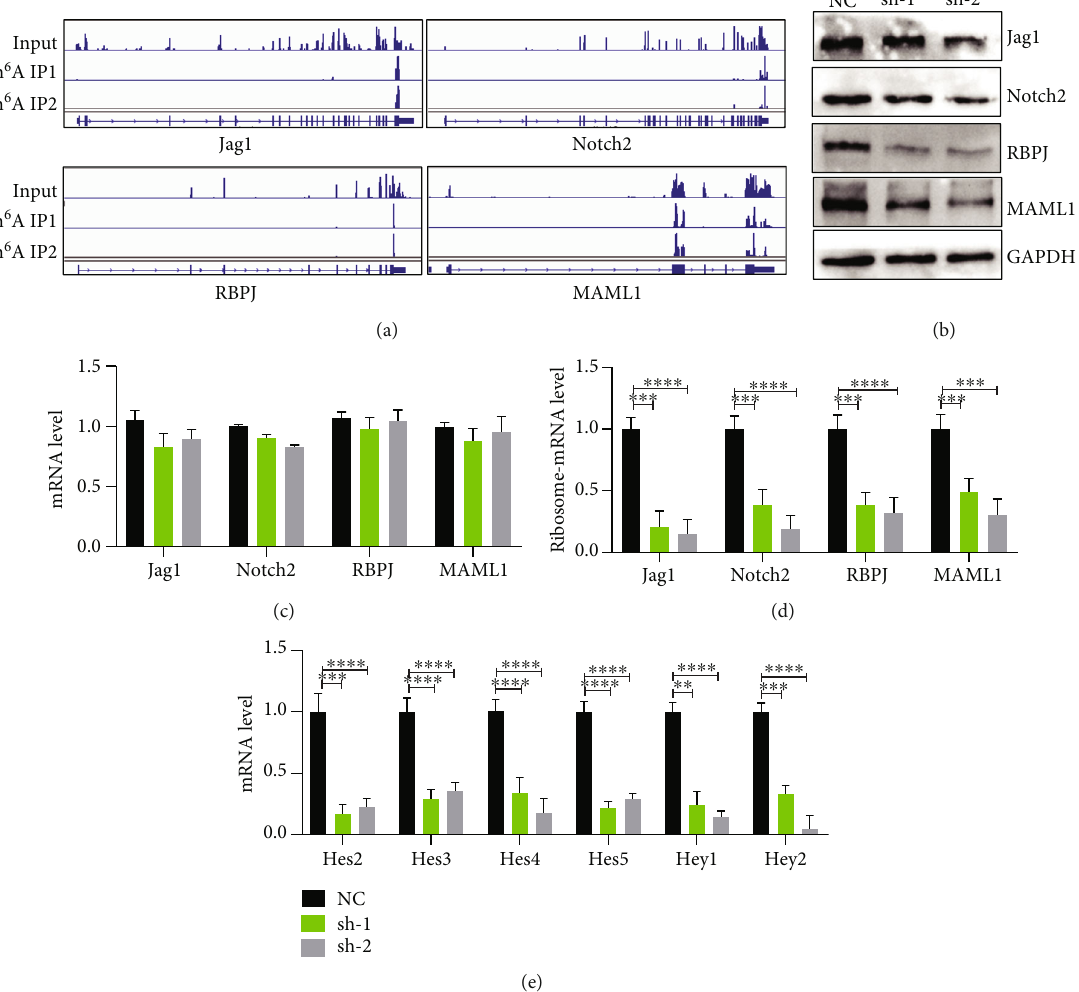
Figure 6: METTL3 regulates the mRNA translation e ffi ciency of Notch signaling pathway components. (a) The Notch pathway genes with m 6 A modi fi cation. (b) The protein levels of Notch signaling pathway in the METTL3-depleted and control cells. (c) mRNA expression of Notch signaling pathway analyzed by q-PCR. (d) Polyribosome-bound mRNA-qPCR was used to detect translation e ffi ciency. (e) The downstream gene expression of Notch signaling pathway was detected by qRT-PCR. ∗∗∗∗ p < 0 : 0001 ; ∗∗∗ p < 0 : 001 ; ∗∗ p < 0 : 01 . NC: negative control; sh-1: METTL3 shRNA-1; sh-2: METTL3